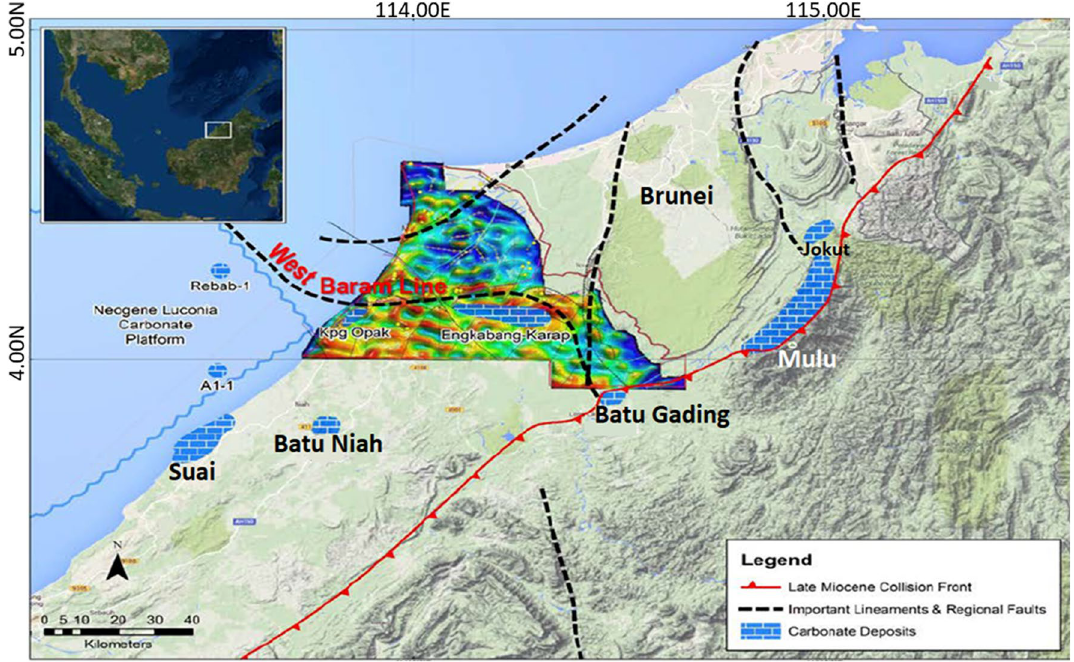
Fig. 15 Distribution of on onshore carbonate rocks in NW